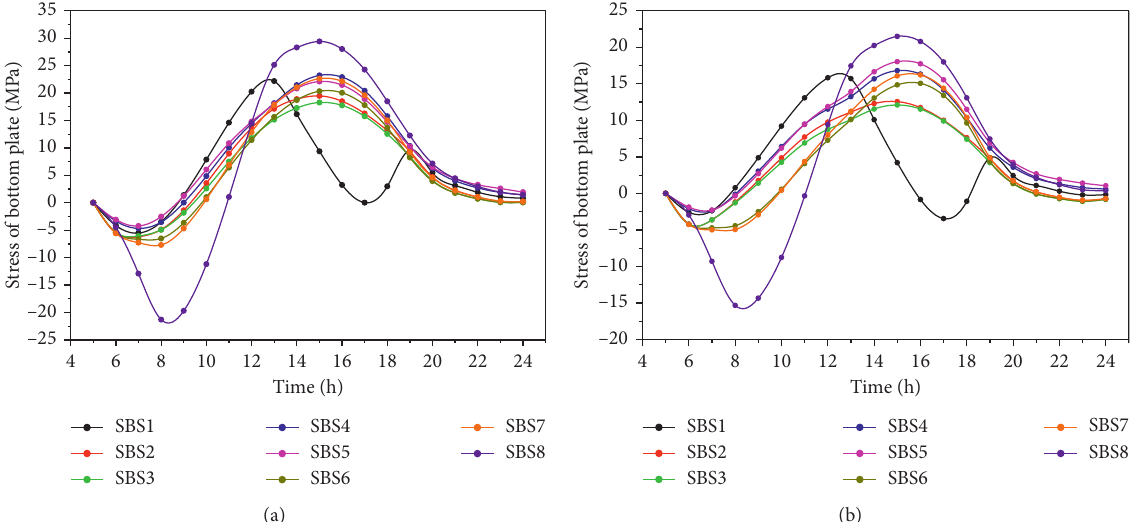
Figure 20: The stress variation of the bottom plate at segment S7 and segment M13. (a) The stress variation of the bottom plate at segment S7. (b) The stress variation of the bottom plate at segment